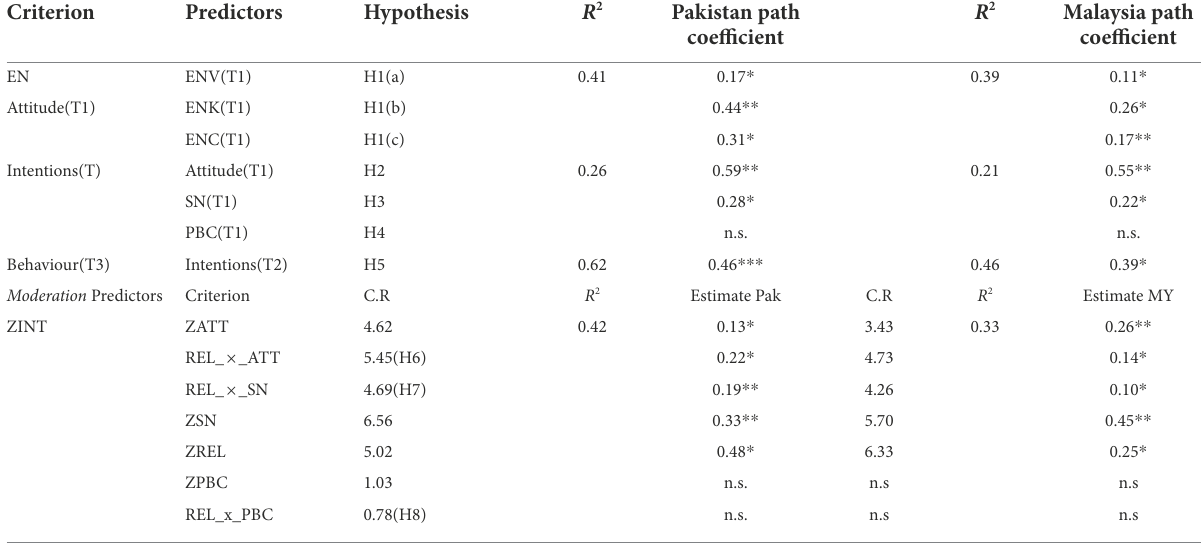
TABLE 4 Results regarding the main effects and the moderated regression analyses.